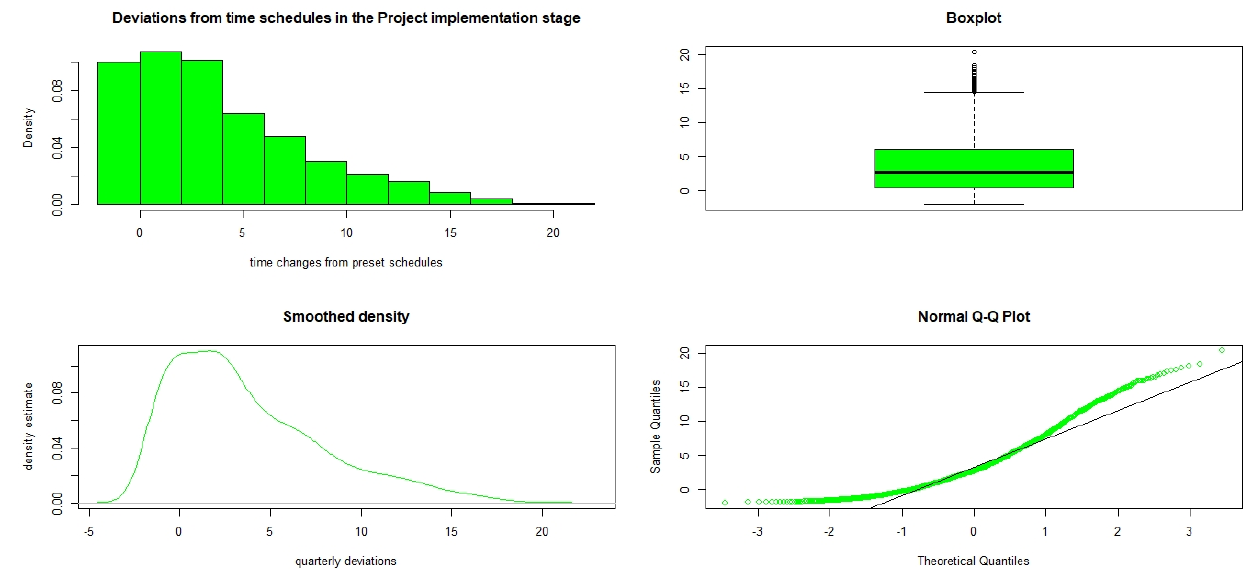
Figure 8. Deviations in time schedules for the project implementation stage (PIS).